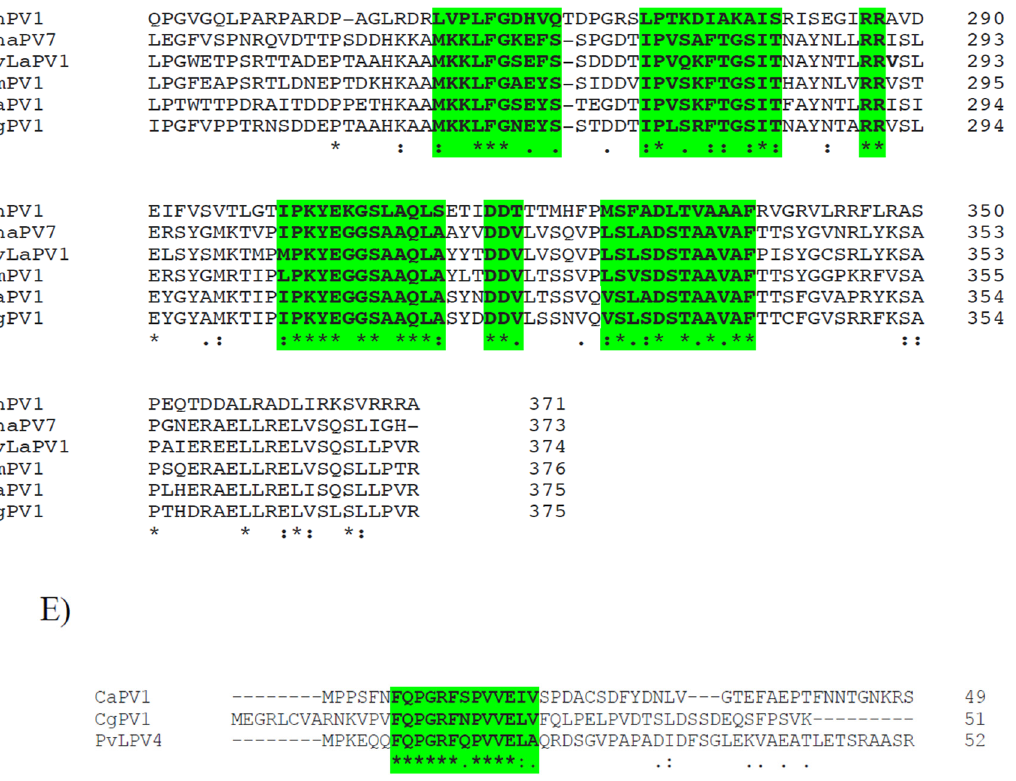
Figure 2. ( A ) Schematic representation of the CaPV1 genome structure. ORF1 encodes an RdRp and ORF2 encodes a hypothetical protein (comparable to coat protein, CP). ( B ) Comparison of the 5 ′ - and 3 ′ -terminal sequences of dsRNA-1, dsRNA-2 and dsRNA-3. ( C ) Multiple alignment of the sequences of the conserved motifs in the RdRps of CaPV1 and other partitiviruses. The six conserved motifs are indicated by the colored boxes. ( D ) Several conserved regions were discovered in a multiple sequence alignment of hypothetical proteins encoded by CaPV1 and closely related viruses from the Partitiviridae family. ( E ) Alignments of ORF4 product of CaPV1 with the hypothetical proteins encoded by dsRNA-3 of CgPV1 (QED88098) and PvLaPV4 (QHD64811).